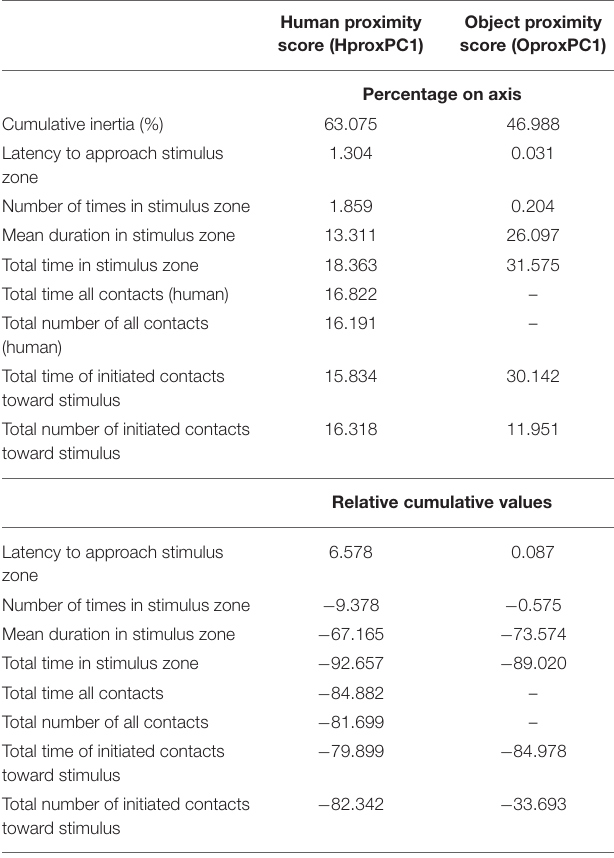
TABLE 6 | Variable loading of PCA describing pig-stimulus behavioral proximity.